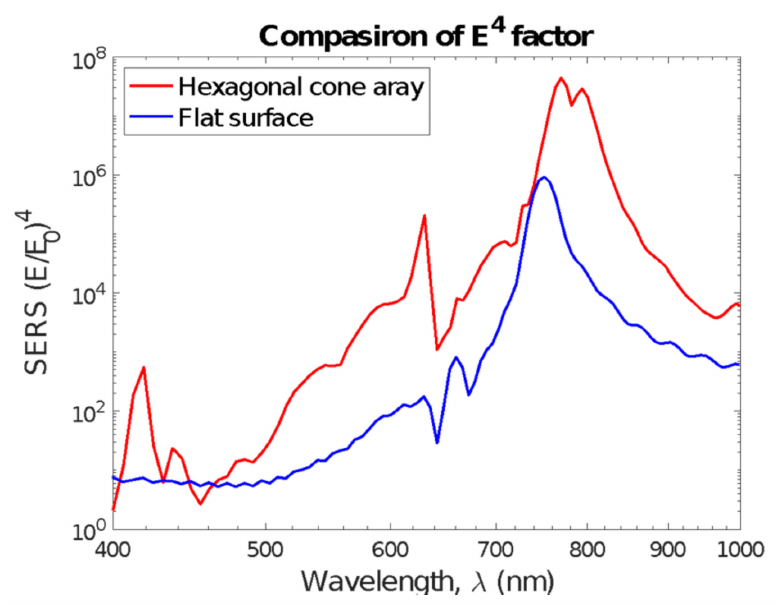
Figure 7. The comparison of E 4 factor between hexagonal dense packing cone array and flat